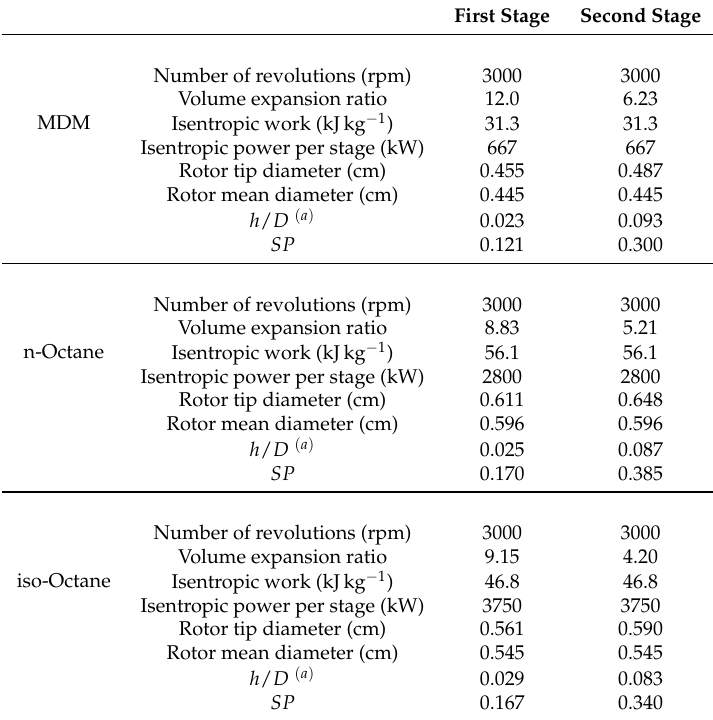
Table 5. Some roughly estimated design parameters for turbines at 3000rpm. The results for MDM are assumed as a